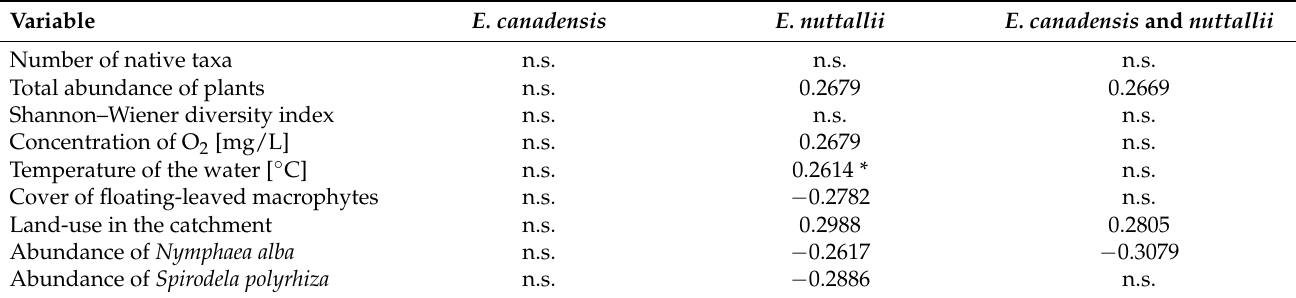
Table 2. Correlation coefficients (Kendall tau ) between the abundance of Elodea canadensis, E. nut- tallii and the sum of both species with diversity indices of native flora as well as with selected environmental parameters. Only significant ( p < 0.05) correlations are shown. (* p = 0.05).